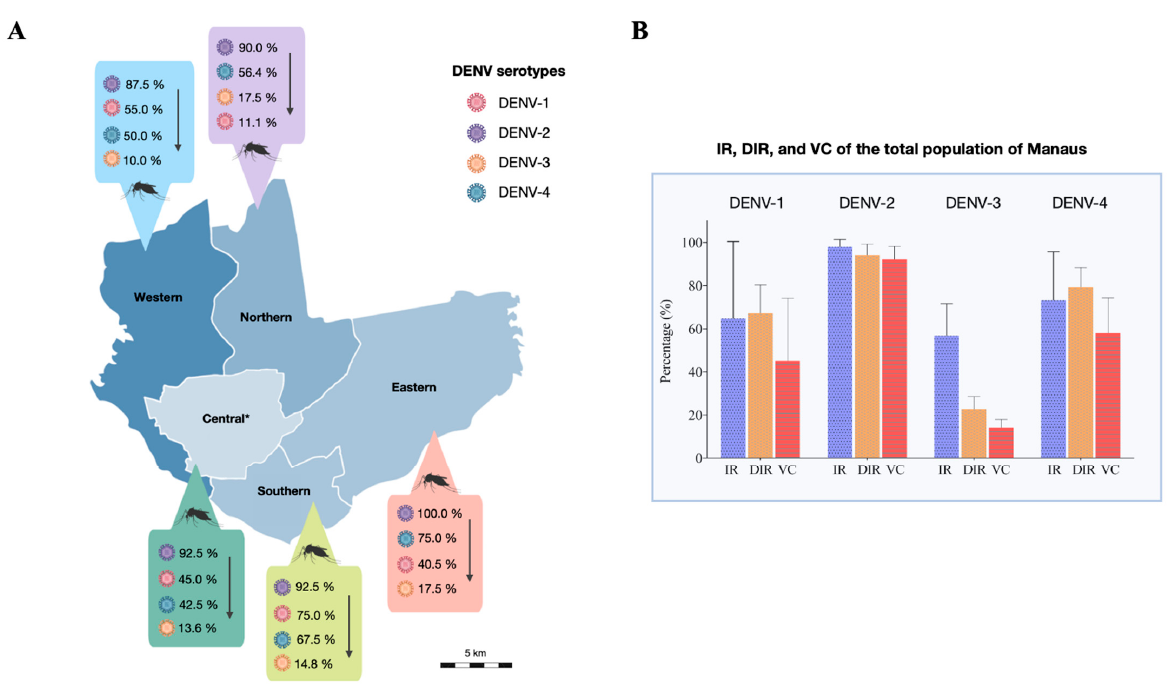
Figure 2. Variability in the infection rate (IR), disseminated infection rate (DIR) and the assumed vector competence (VC) of the Ae. aegypti populations for DENV serotypes 1–4. ( A ): Map of the urban area of Manaus showing the mosquito VC for each population (derived from distinct geographic districts), considering the order of decreasing values. The south-central and west-central districts were combined and named the central district to avoid inconsistency in the size of the collection areas. ( B ): IR, DIR, and VC averages of all populations show similarity in infection patterns between DENV-1 and DENV-4. The error bars on the graph are the standard deviations. The standard deviations of the IRs, DIRs, and VCs, respectively, were 28.7%, 10.6%, and 23.3% for DENV-1; 2.7%, 4.1%, and 4.7% for DENV-2; 12%, 4.9%, and 3.1% for DENV-3; and 18.2%, 7.5%, and 13.1% for